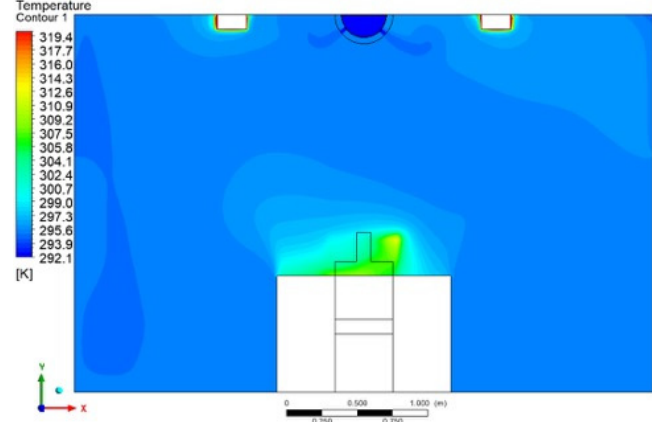
Figure 12. The temperature distribution of the Z = 2 m section.